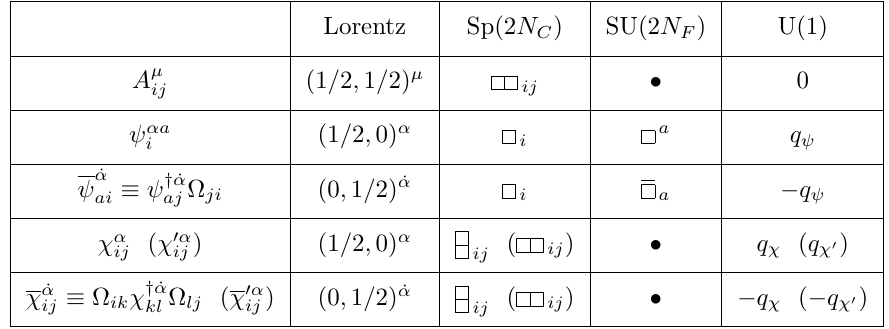
Table 2 . The transformation properties of the HC gauge bosons A and fermions ψ and χ ( χ 0 ). The Sp(2 N ) indexes are denoted by i, j, . . . , and Ω is the antisymmetric invariant tensor of Sp(2 N C ij Lorentz vector and spinor indexes are denoted by µ, ν, . . . , and α, β . . . , ˙ α, ˙ β, . . . , respectively. The flavour SU(2 N ) indexes are denoted by a, b, . . . . The bullet stands for the singlet F